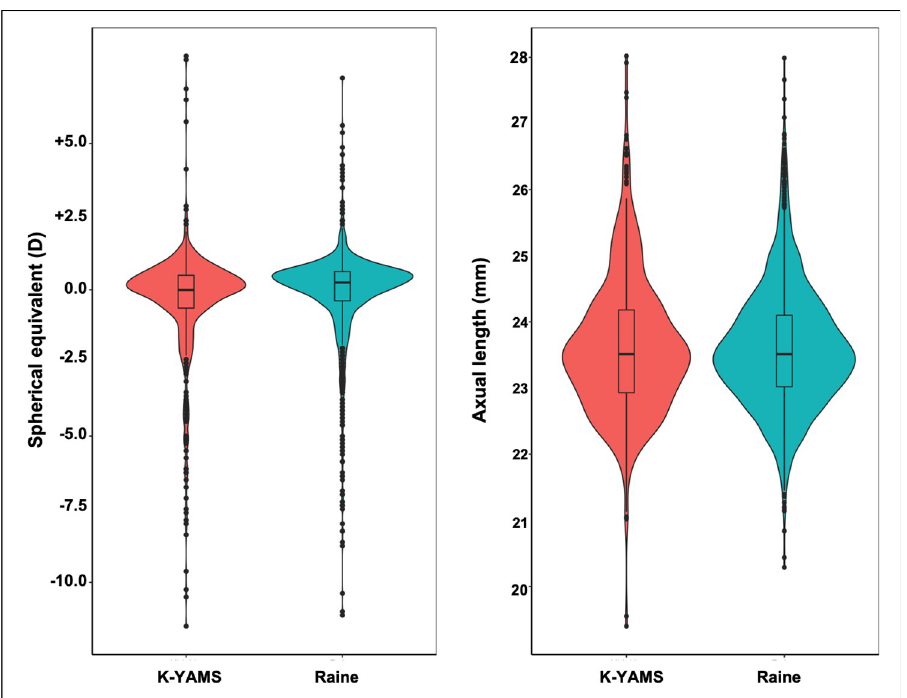
Fig 3. Distributions of refractive errors (D) and axial lengths (mm) in the Raine Study and K-YAMS cohorts. https://doi.org/10.1371/journal.pone.0266909.g003 Using the raw retinal measurements, each millimetre increase in axial length was associated with thinner retinal in the non-central region by -2.1 to -3.0 μ m in the Raine Study Gen2 cohort and by -2.0 to -3.4 μ m in the K-YAMS cohort (all p < 0.001; Table 2 ). Using the cor- rected data, longer axial length remained significantly associated with thinner retinal thickness